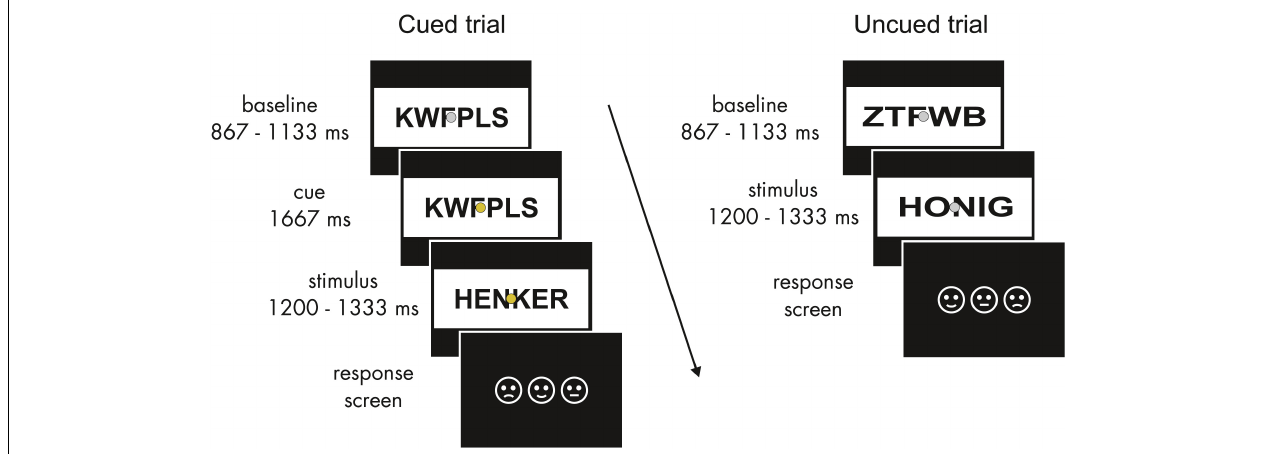
FIGURE 1 | Schematic structure of experimental trials. In cued trials (left), after the baseline period a fixed time period of 1667 ms with a color change of the fixation dot allowed for expectations about the emotional valence of the upcoming word. Uncued trials (right) were identical except for the cue. Baseline and word stimuli flickered at 15 Hz. The response screen indicated the trial-by-trial key